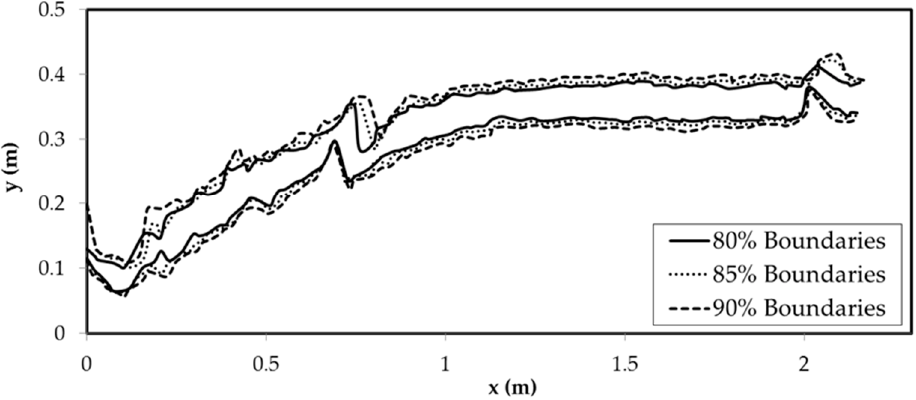
Figure 5. Bands containing the 80%, 85% and 90% of the points measured along the hydraulic jump longitudinal axis with LIDAR technology.